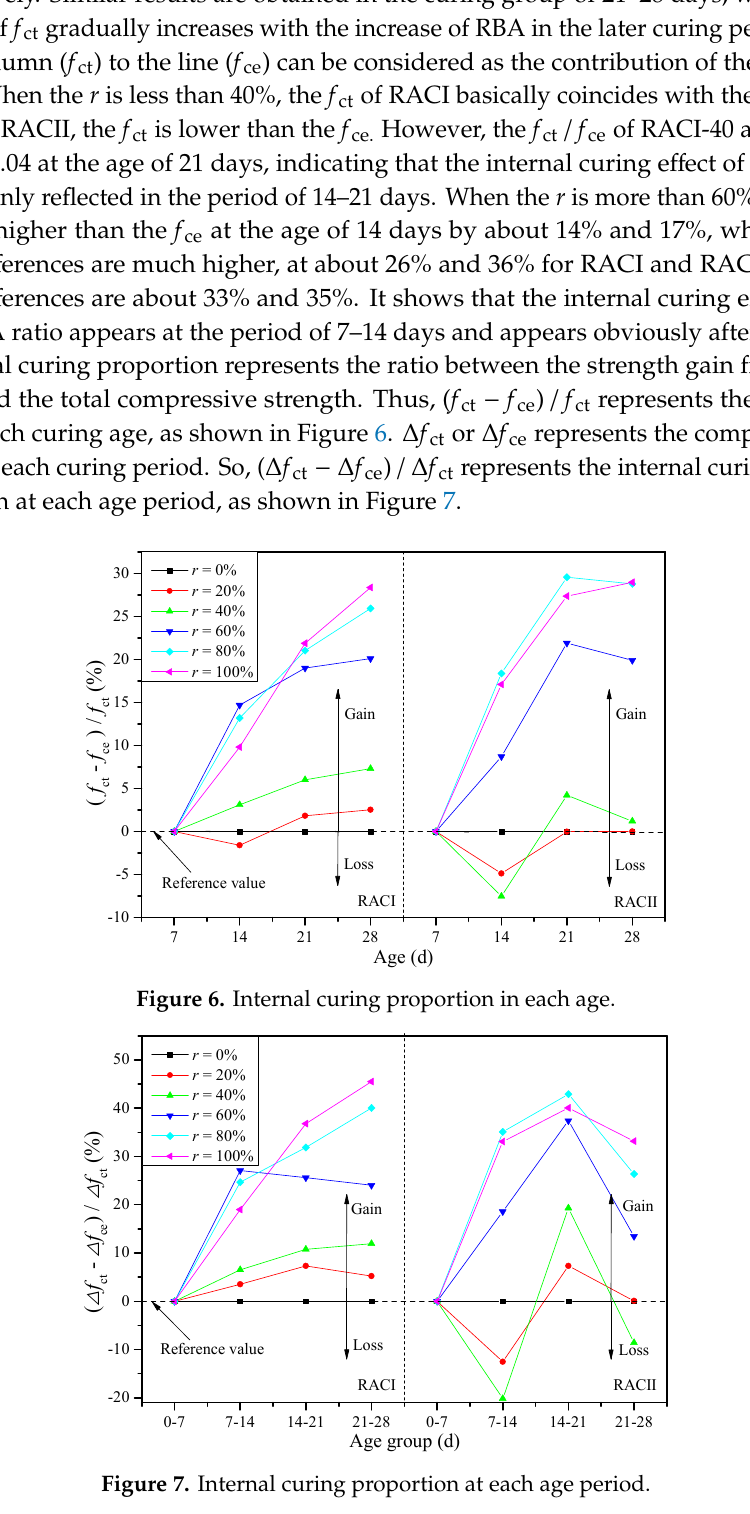
Figure 7. Internal curing proportion at each age period.